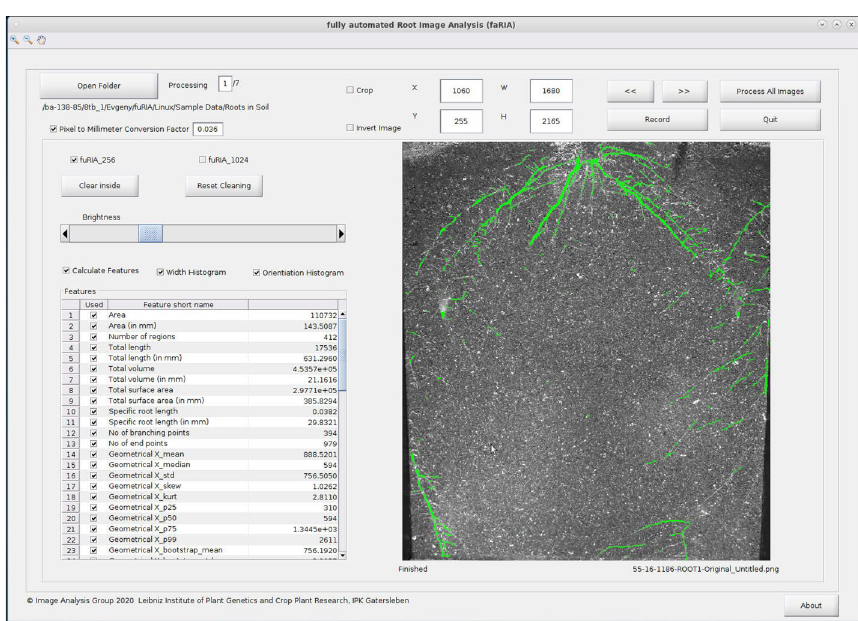
Figure 12. Graphical user interface of faRIA. Green colour pixels represent root regions automatically segmented by the U-Net